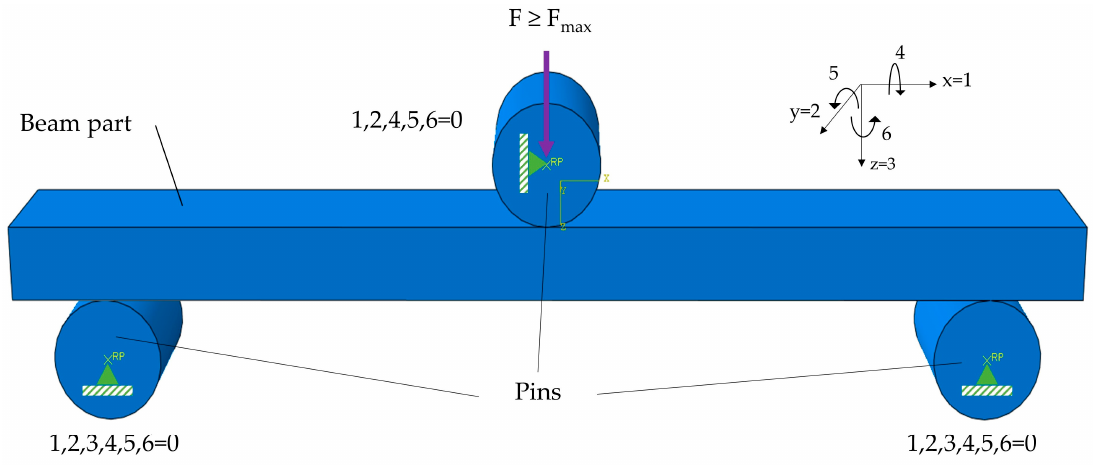
Figure 1. Illustration of parts and boundary conditions assigned in the finite element (FE) model. 3D rigid elements R3D4 (4-node bilinear quadrilateral) and R3D3 (3-node triangular facet) were assigned to mesh pins. To create a mesh for the beam, C3D8R (8-node linear brick) solid elements with reduced integration were